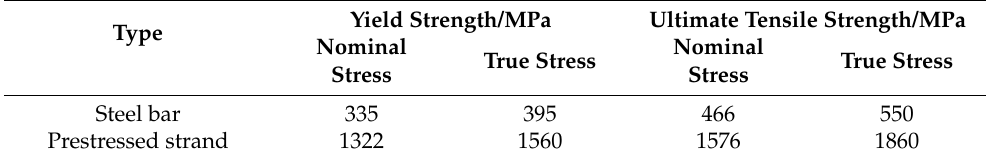
Table 4. Details in the stress-strain curves of reinforcements and prestressed strands.